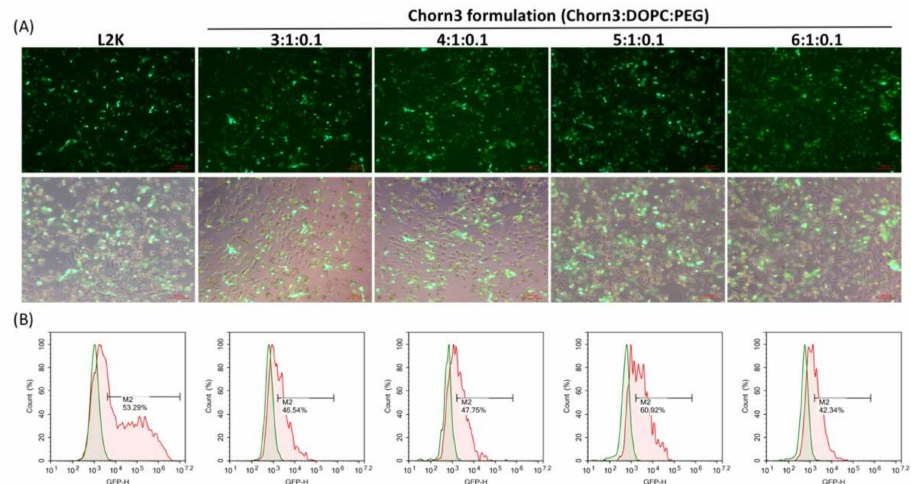
Figure 6. Plasmid transfection by Chorn3 LNP. ( A ) Fluorescence microscopy images of HEK293T cells transfected with pcDNA-eGFP plasmid complexed to lipofectamine 2000 (L2K) or Chorn3. ( B ) Quantification of GFP expressing cells by flow cytometry. HEK293T cells were transfected with pcDNA-eGFP plasmid complexed to Chorn3 formulations. 24 h later, GFP expressing cells were quantified by flow cytometry.